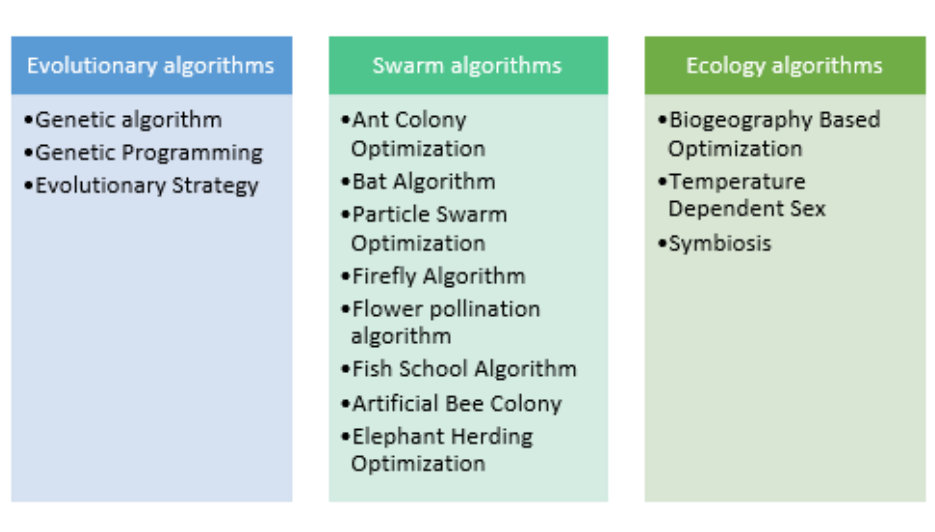
Figure 1. Bio-inspired algorithms .